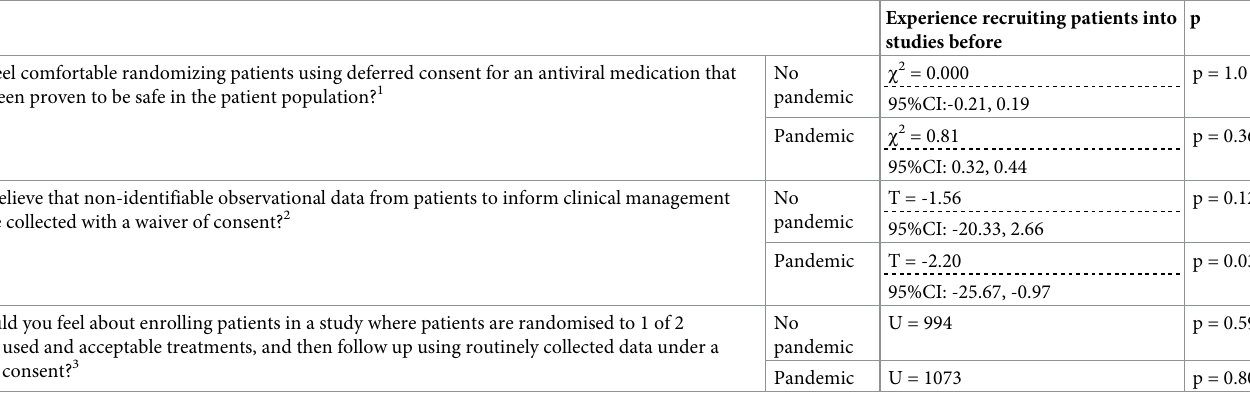
Table 2. Whether experience recruiting patients into studies affects your beliefs on research when there is a pandemic.